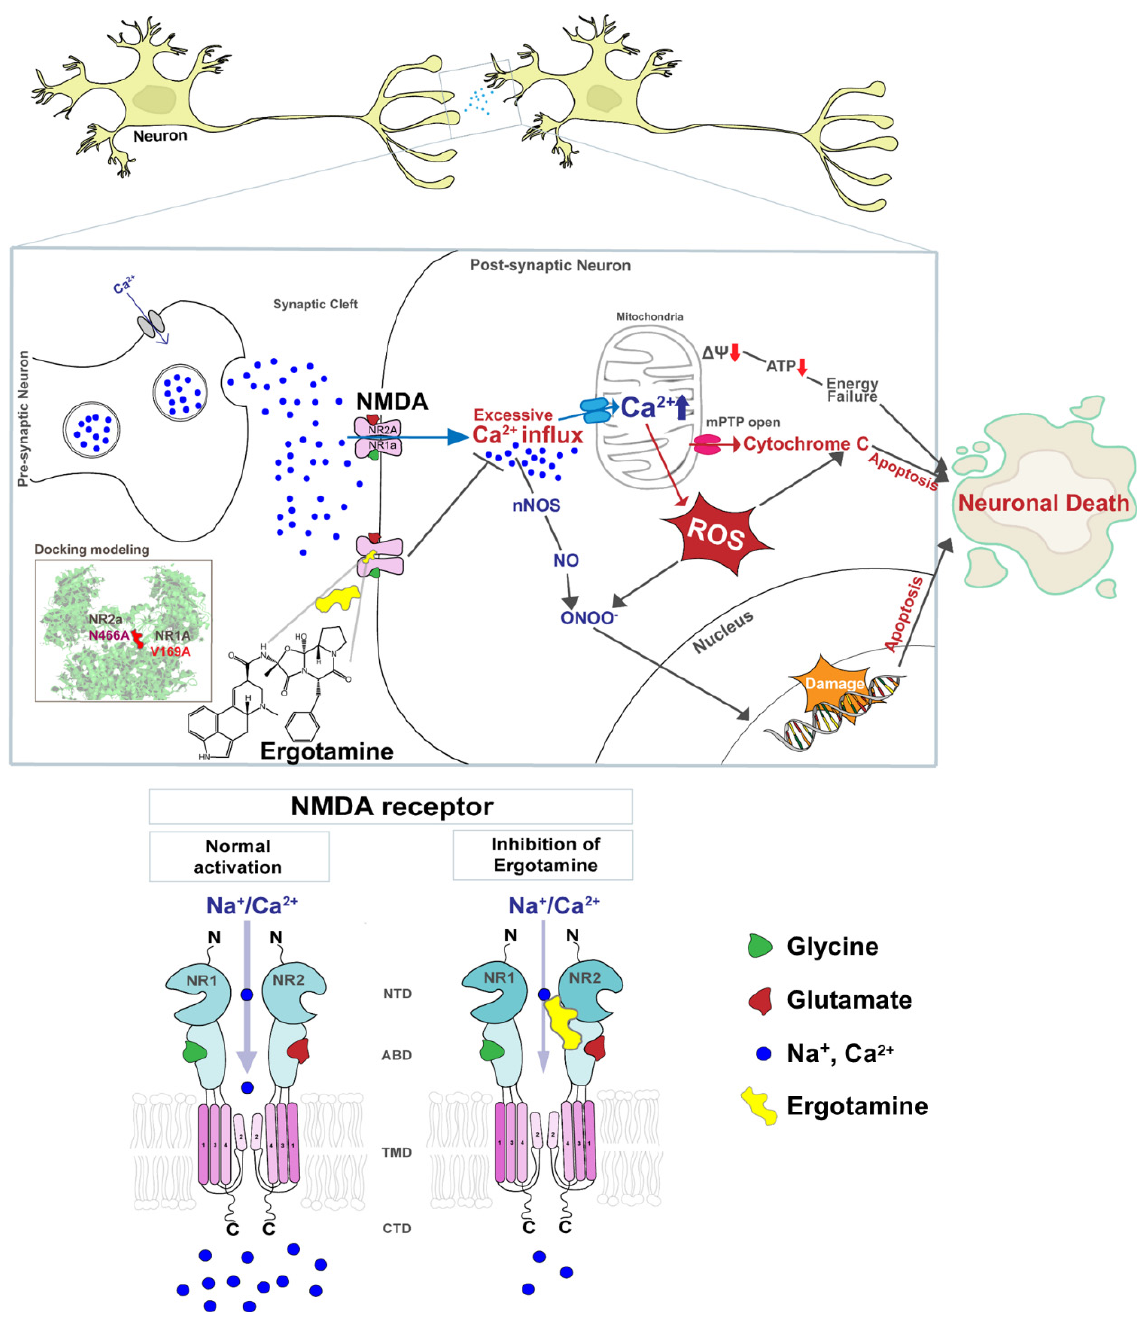
Figure 1. Schematic diagram of the NMDA receptor and excessive Ca 2+ ions influx induces cellular apoptosis in the event of the overstimulation of this receptor. The overstimulation of NMDAR increases the intracellular Ca 2+ influx, thus increasing ROS accumulation, damaging genetic material, and ultimately leading to apoptosis. Ergotamine derived from ergot alkaloids can modulate intracellular Ca 2+ concentration by inhibiting hyperstimulation to